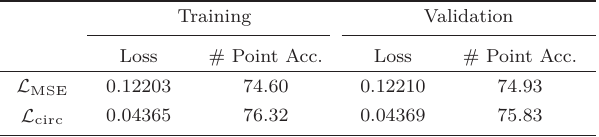
Table 1 Error and accuracy measures during training and testing with two different loss functions. Loss denotes the MSE distance between the ground truth and predicted positions of control points (distances are normalized to lie in the unit interval). # Point Acc. denotes the frequency of predicting the number of control points correctly